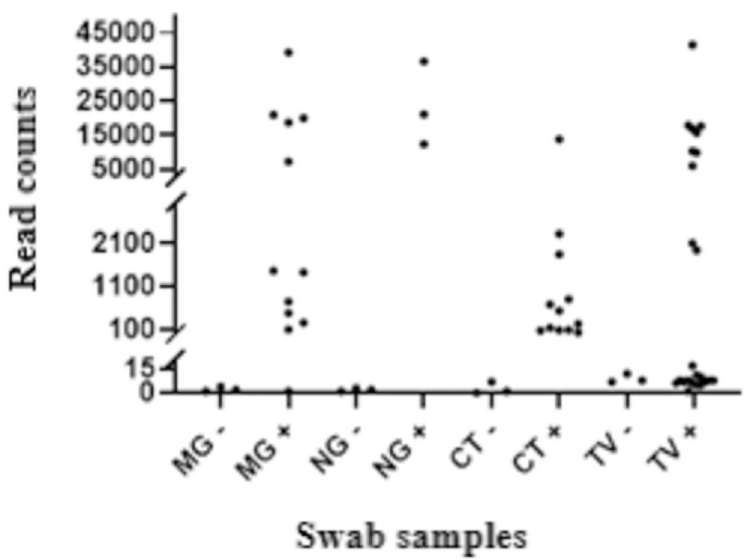
Fig 1. Pathogen read counts in the qPCR positive and negative STI samples analyzed by single gene targeted PCR nanopore